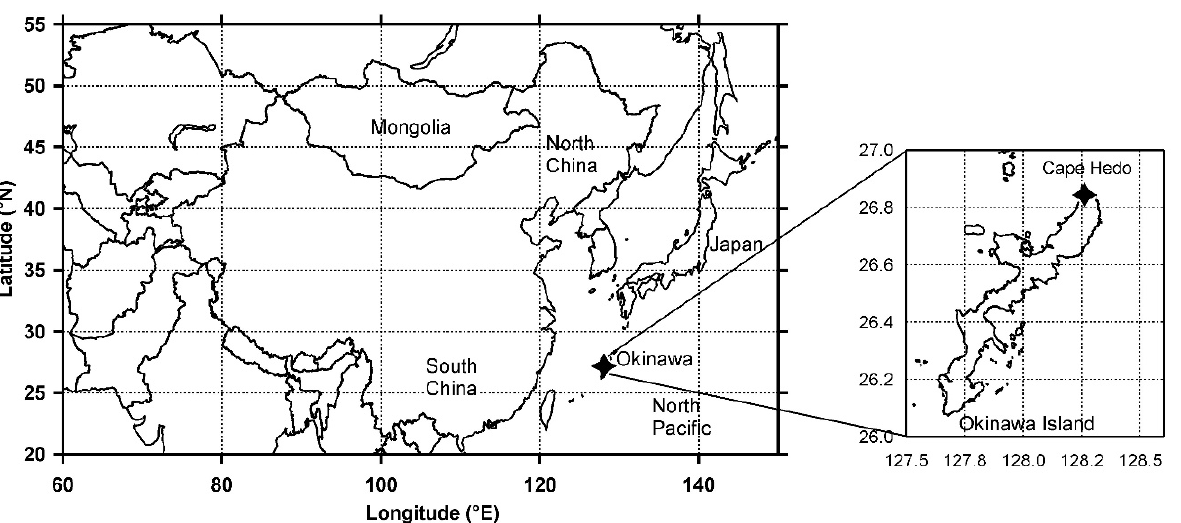
Figure 1. Map of Okinawa Island, Japan, with sampling location (Cape Hedo) for aerosols (PM 1.0 ) and on-line AMS measurements.